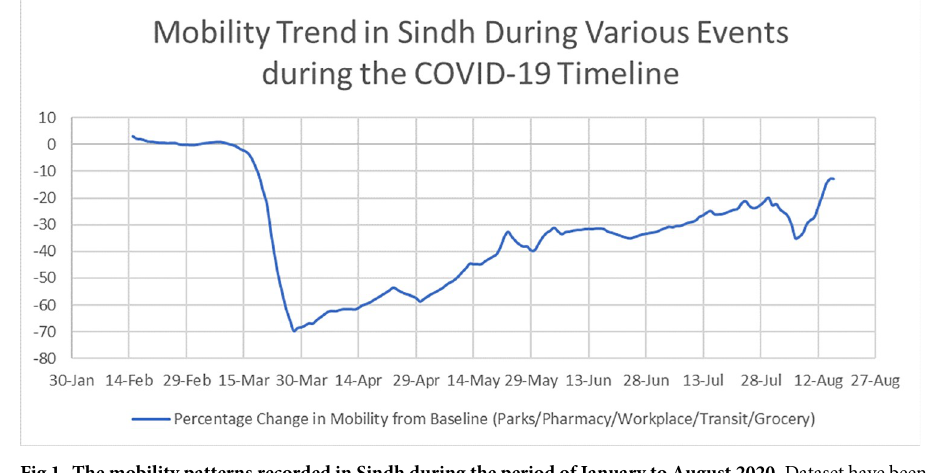
Fig 1. The mobility patterns recorded in Sindh during the period of January to August 2020. Dataset have been taken from publicly online database (www.google.com/covid19/mobility/). This figure depicts the percentage change in mobility during the period of 30 th Jan to 16 th August 2020. Mobility patterns have been recorded for people leaving their residence for visiting parks, pharmacies, workplace, bus or train stations and for grocery